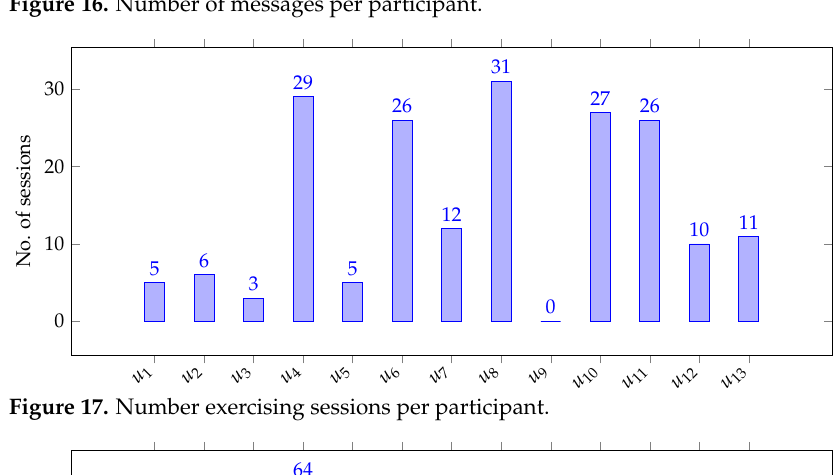
Figure 17. Number exercising sessions per participant.